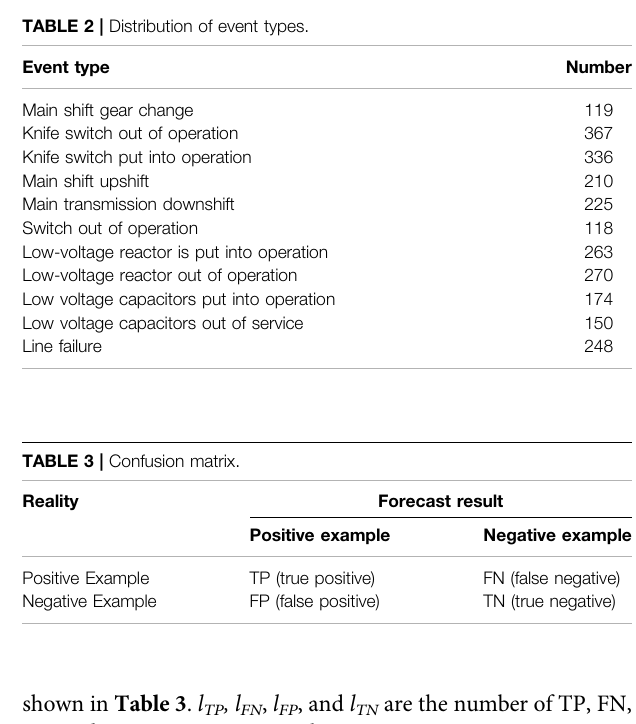
FIGURE 5 | Neural network classi fi cation model structure.